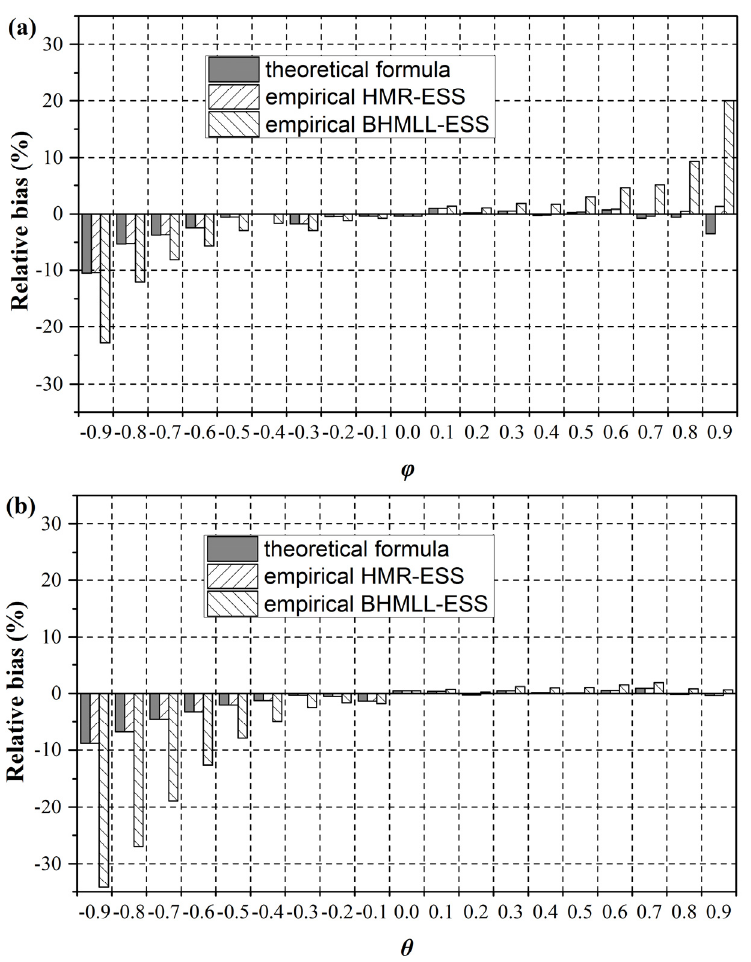
Figure 4. Comparison of the relative bias of the rho variance calculation via theoretical and empirical formulae ( n = 100): ( a ) AR(1); ( b ) MA(1).